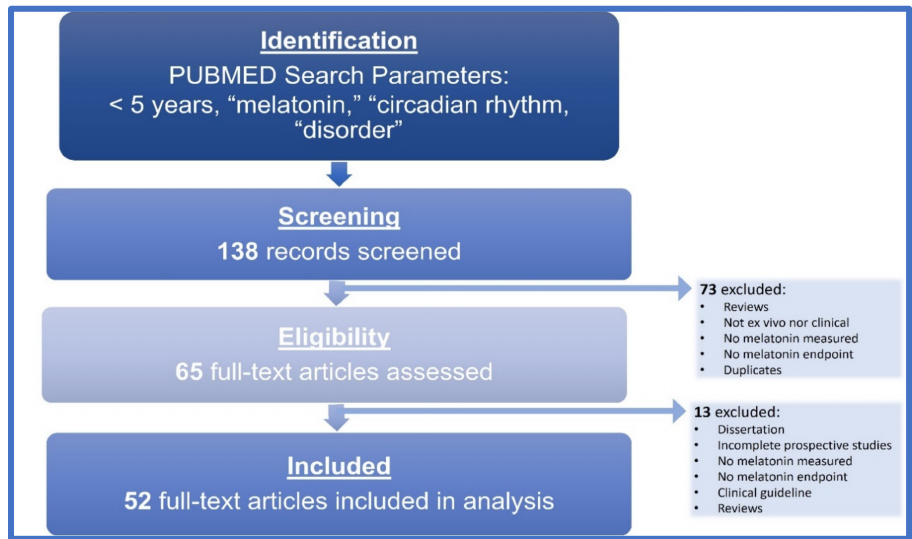
Figure 1. Literature selection flow chart. All steps of the literature search are represented within the flow chart, resulting in 52 full-text articles included in this